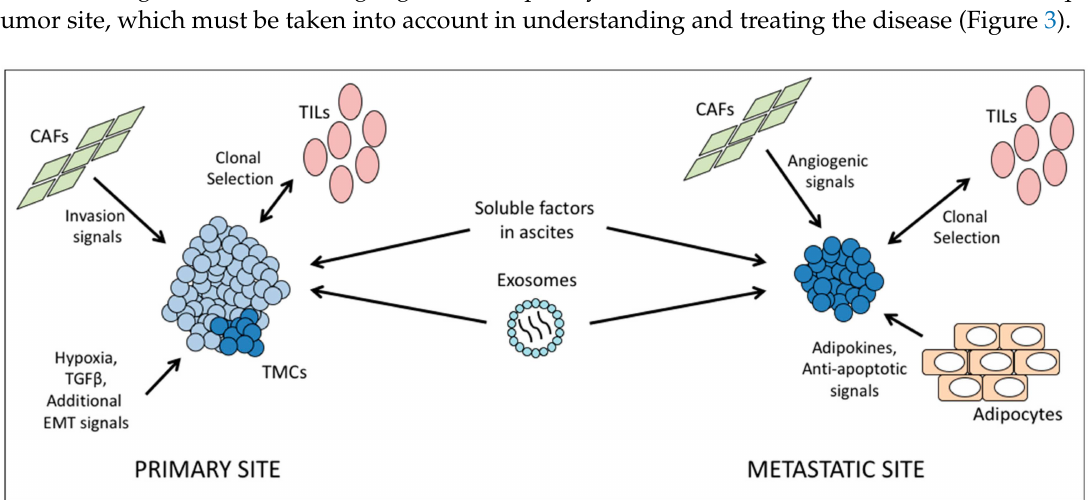
Figure 3. Tumor microenvironment influences tumor cell heterogeneity. Left, at the primary site, hypoxia and epithelial to mesenchymal transition (EMT) signals lead to di ff erentiation of transitional mesenchymal cells (TMCs), a metastatic population. Local fibroblasts regulate adherence and invasiveness of cell populations. Tumor infiltrating lymphocytes (TILs) select clonal populations, while tumor diversity opposes immune action. Center, circulating exosomes and a wide variety of soluble signals from ascites fluid can a ff ect tumors throughout the body and tumor cells in transit. Right, at the metastatic niche such as the omentum, cancer-associated fibroblasts (CAFs) can provide angiogenic signals and prepare a niche for tumor cells. Adipocytes signal to tumor cells and help colonizing